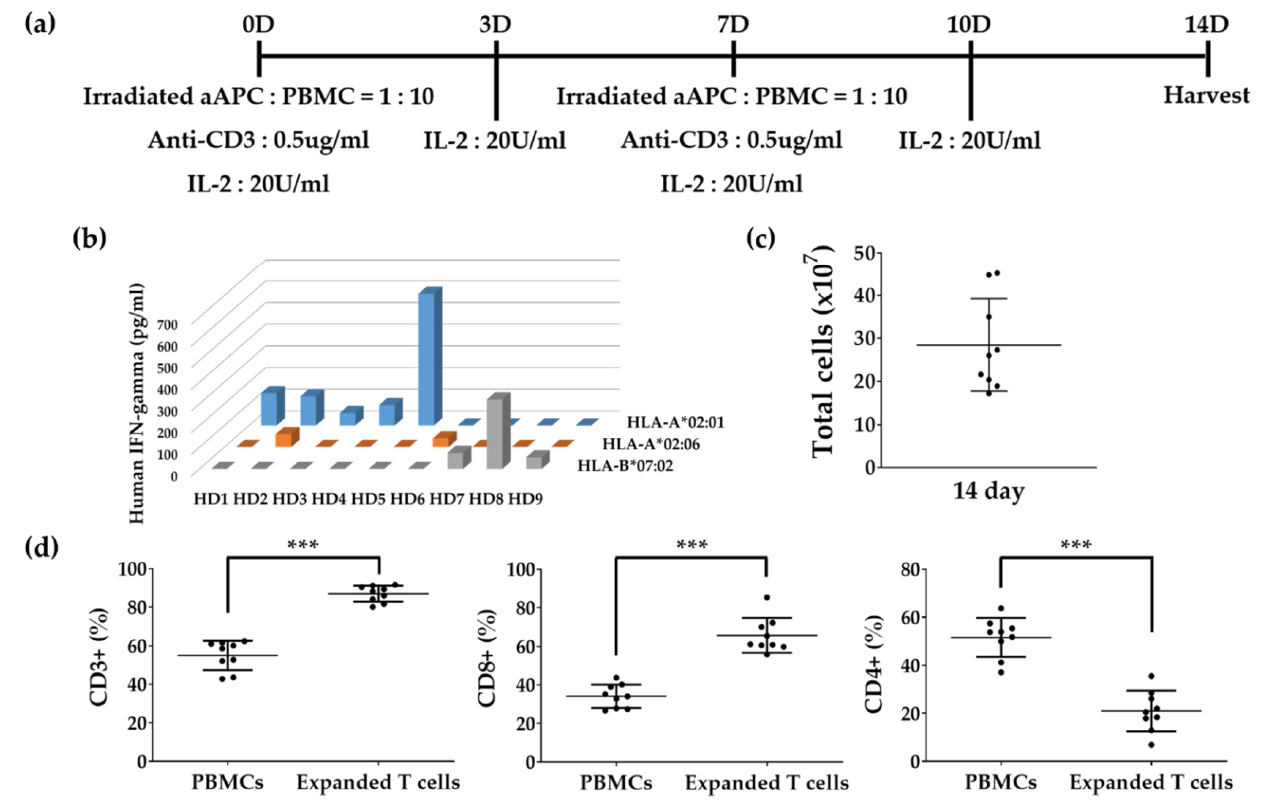
Figure 3. In vitro expansion of T cells. ( a ) Overview of T cell expansion from PBMCs using aAPCs expressing co-stimulatory molecules and anti-CD3. ( b ) HLA restriction and reactivity of 9 donors with positive T cell response to pp65 antigen. PBMCs of each donor were cultured with aAPCs expressing a single HLA class I allotype and pp65 whole antigen for 24 h and the level of IFN-γ in the culture supernatants was measured by ELISA. ( c ) Total number of cells at 14 day after the expansion of PBMCs. Dots represent individual donors (n = 9). Error bars show the median ± in-terquartile range. ( d ) Changes in the proportion of CD3 + , CD8 + , and CD4 + T cells after two weeks of expansion were measured by flow cytometry. Dots represent individual donors (n = 9). p value was calculated by Paired t -test. *** p < 0.0001.